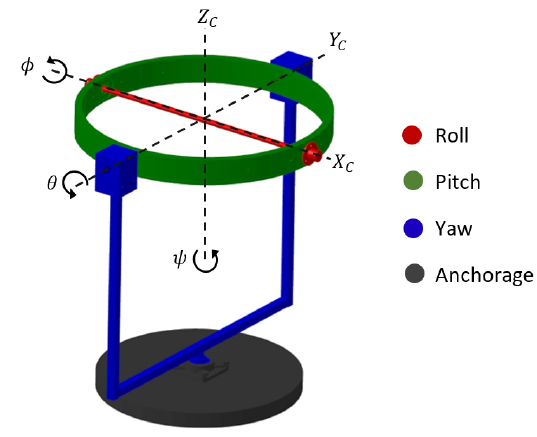
Figure 4. Kinematic description of the gyroscopic platform. Elements in red rotate on X C axis and have the function of enabling roll φ motion. Elements in green enable pitch motion θ rotating on Y C axis. Elements in blue define rotation on Z C axis establishing a yaw orientation ψ . Elements in black are anchors for the entire prototype.